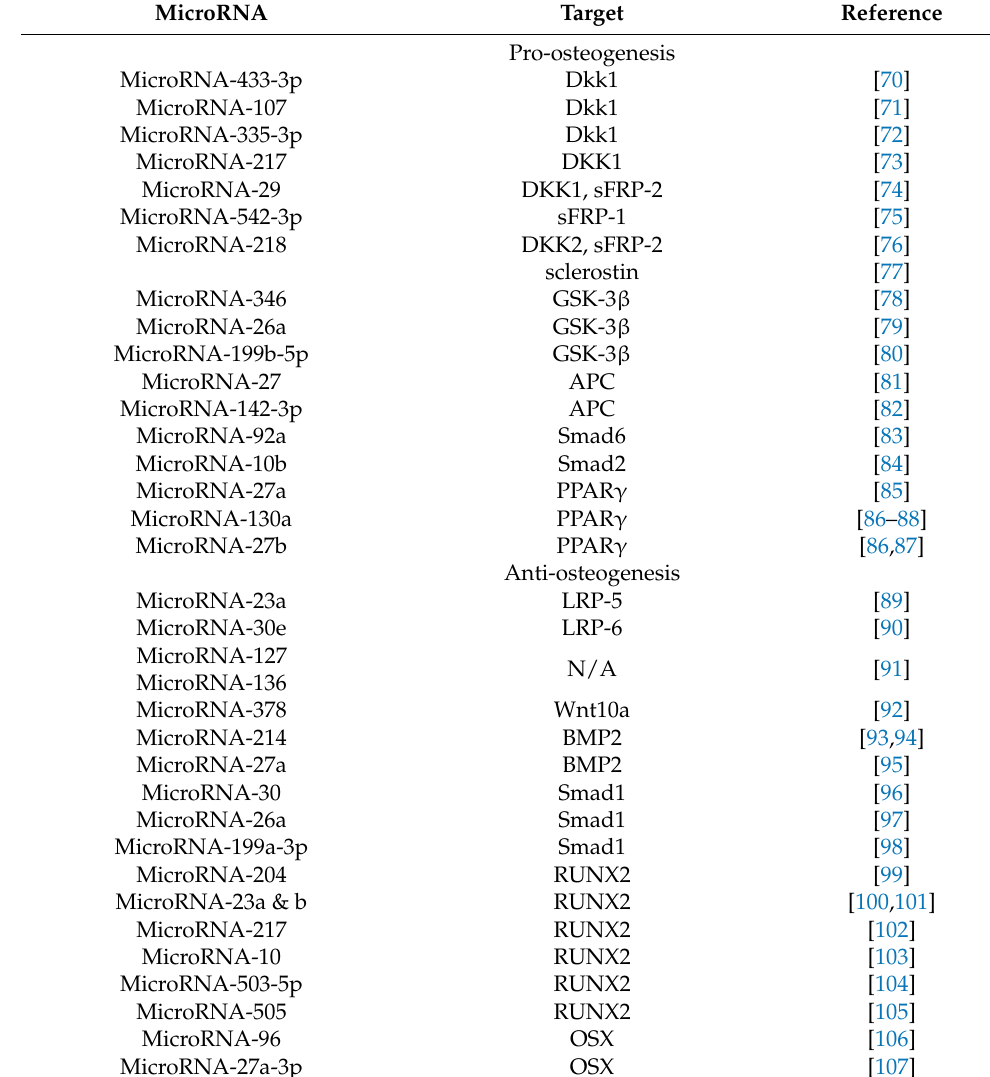
Table 1. A summary of microRNAs and their targets involved in osteogenesis and